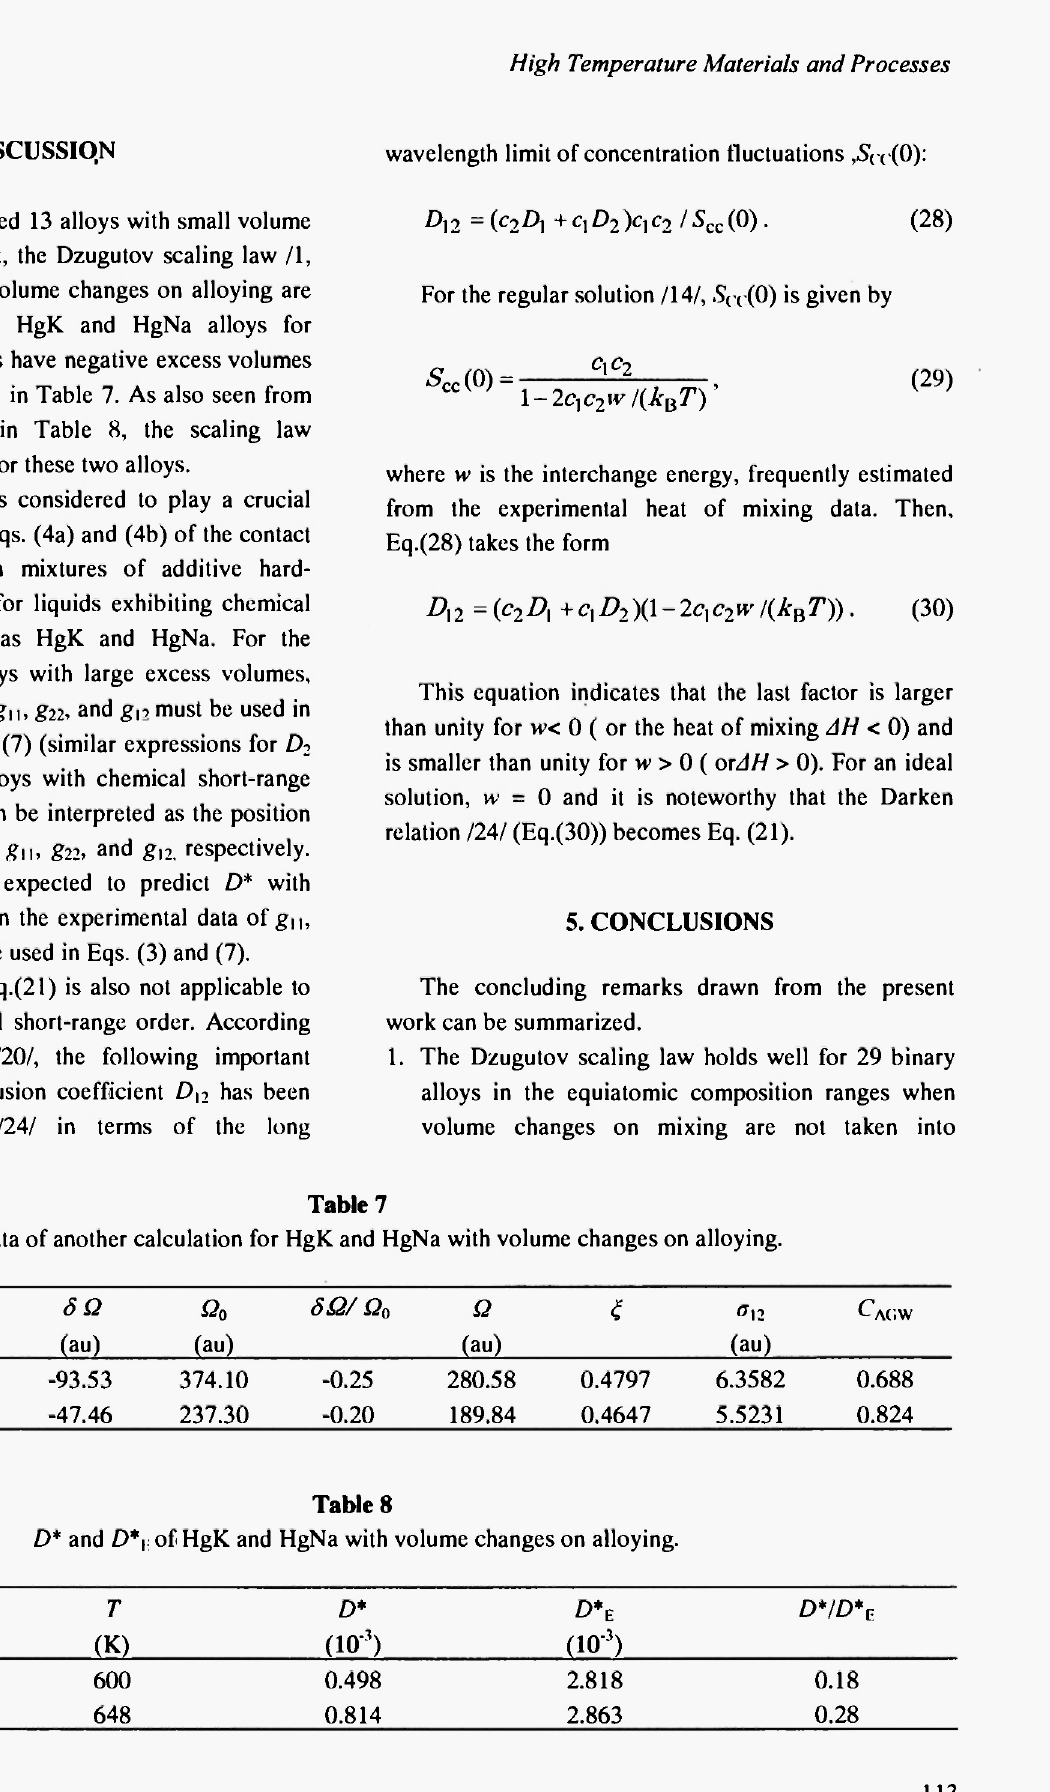
D* and D* v of HgK and HgNa with volume changes on